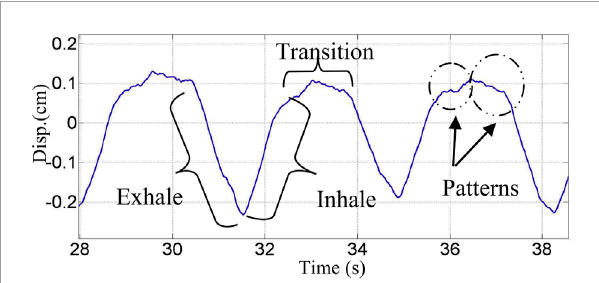
FIGURE 1 Continuous wave 2.4 GHz Doppler radar measured